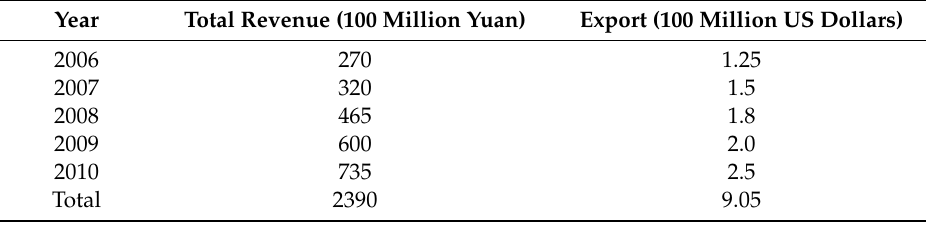
Table 3. Economic benefit growth of the solar water heater industry between 2006 and 2010.